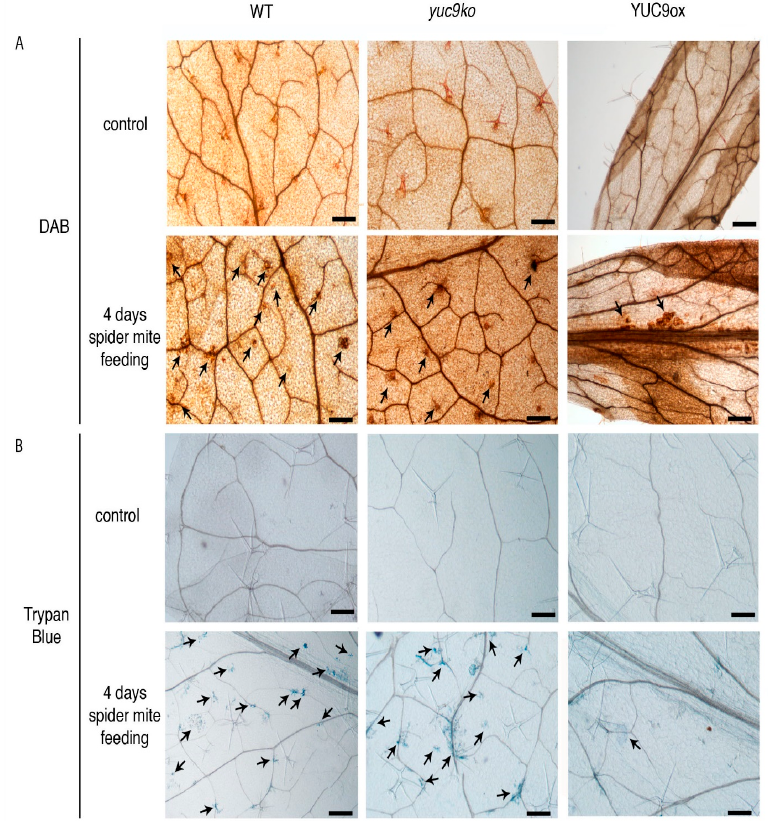
Figure A3. Histochemical analysis after spider mite herbivory. ( A ) DAB staining, ( B ) Trypan blue staining. Arrows indicate H 2 O 2 accumulation and cell death, respectively. Images represent leaf de- tails of control plants (top row) and plants exposed to 4 days spider mite feeding (bottom row). Scale bar = 1 mm. The arrows mark tissue damages caused by mite feeding. Table A1. List of primers used for cloning and qRT-PCR analysis (https://quantprime.mpimp-golm.mpg.de/, last accessed: 8 September 2021) [93].